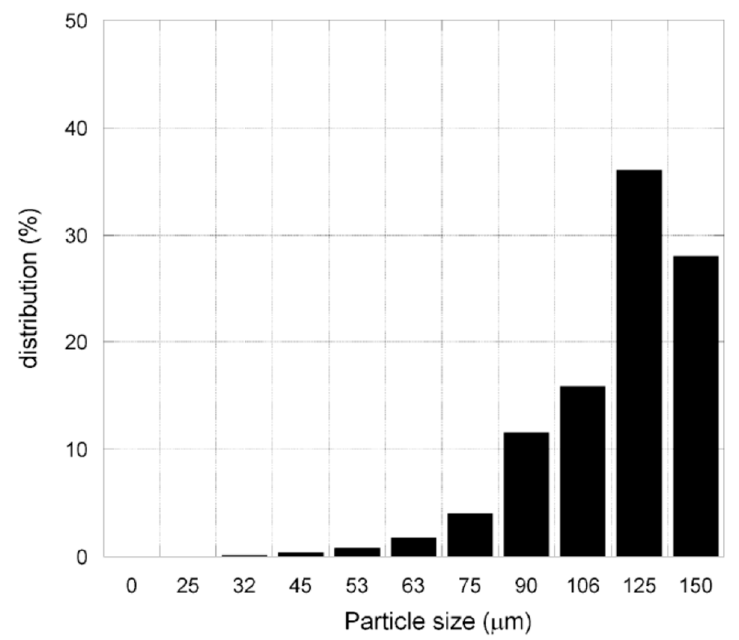
Figure 6. Particle size distribution of Nylon-11 (RilsanD80) by sieve analysis. Reprinted from [30], © 2008, with permission from Elsevier.